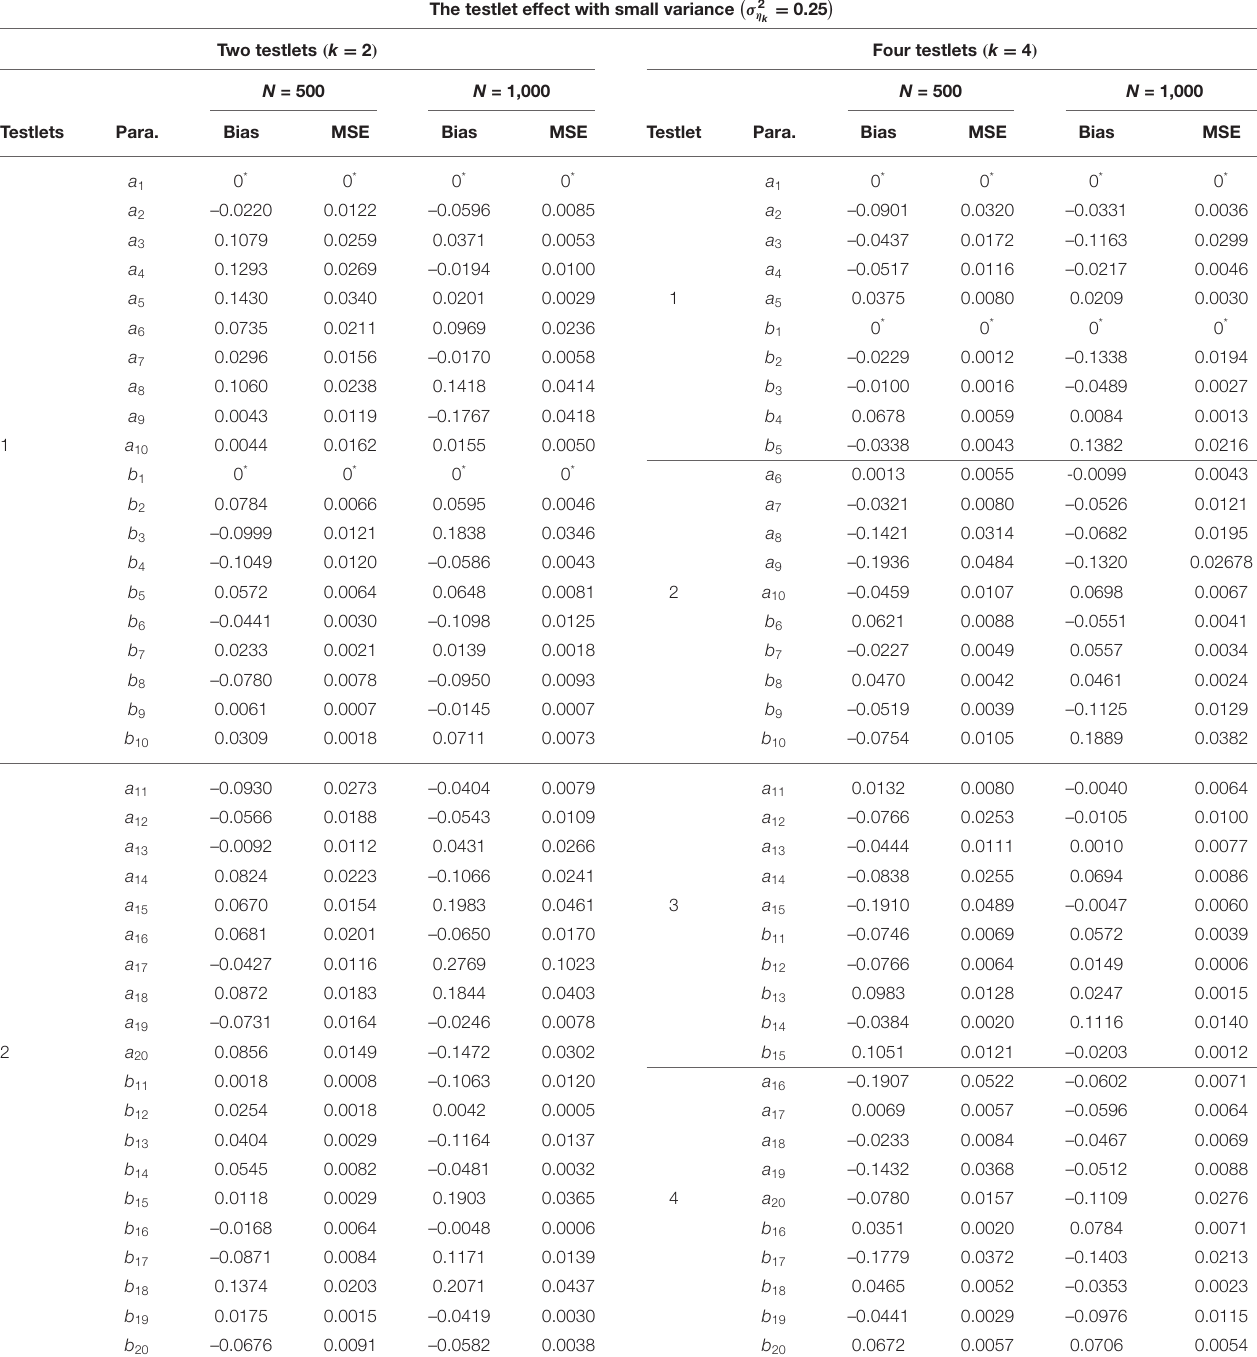
TABLE 2 | Evaluating accuracy of the item parameter estimates based on different simulation conditions in the simulation study 1. The testlet effect with small